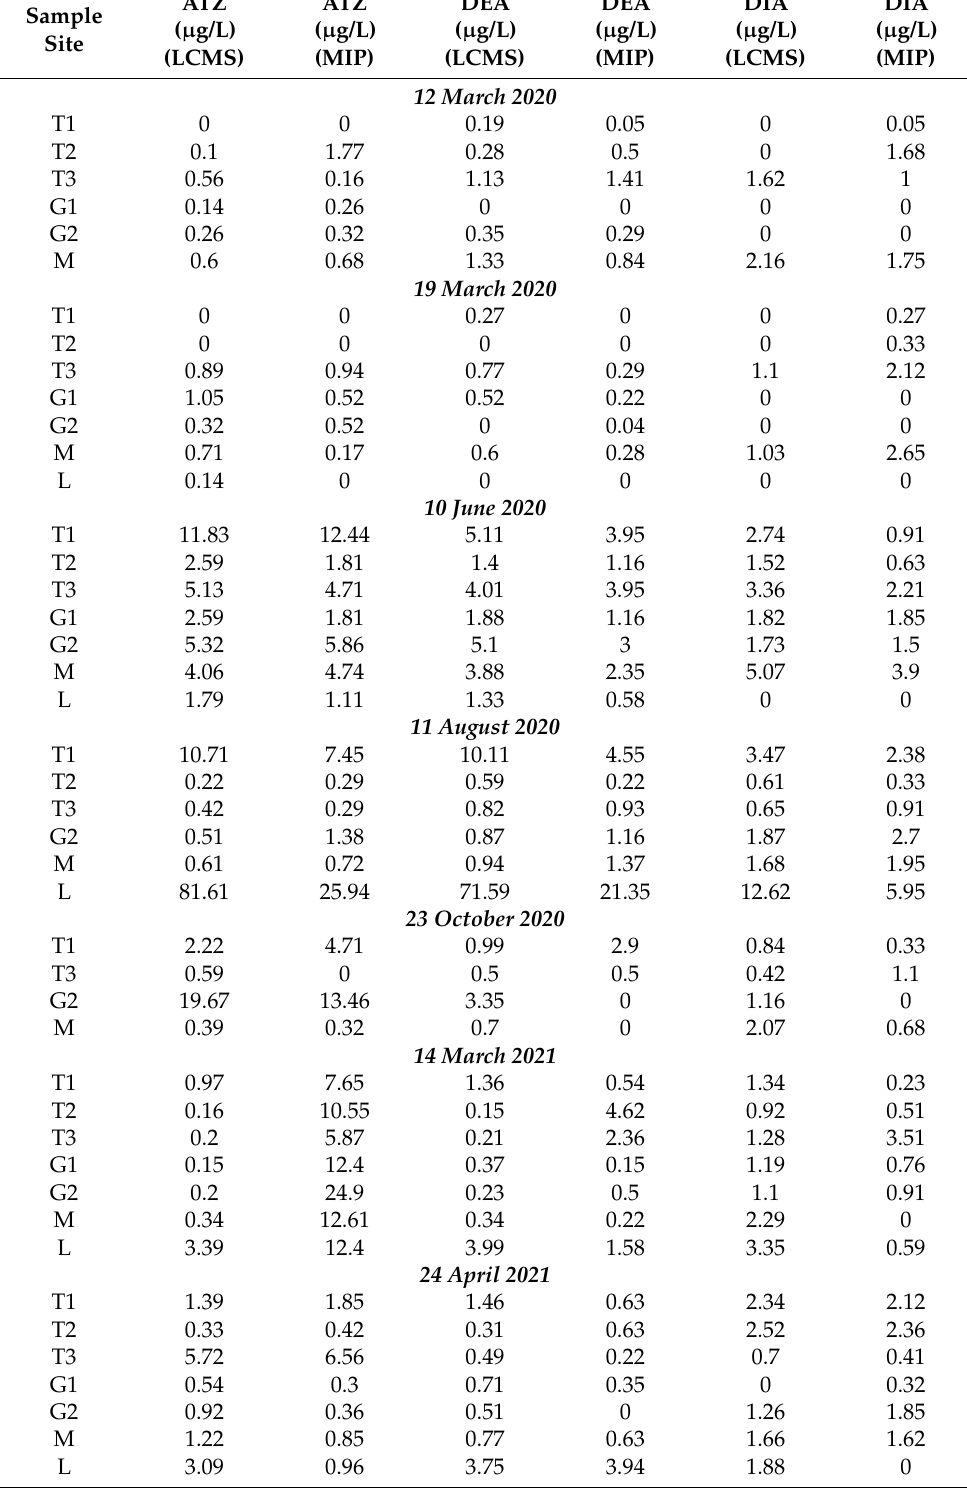
Table 1. Concentration measurement of ATZ, DEA, and DIA using LCMS/MS and MIP sensors.